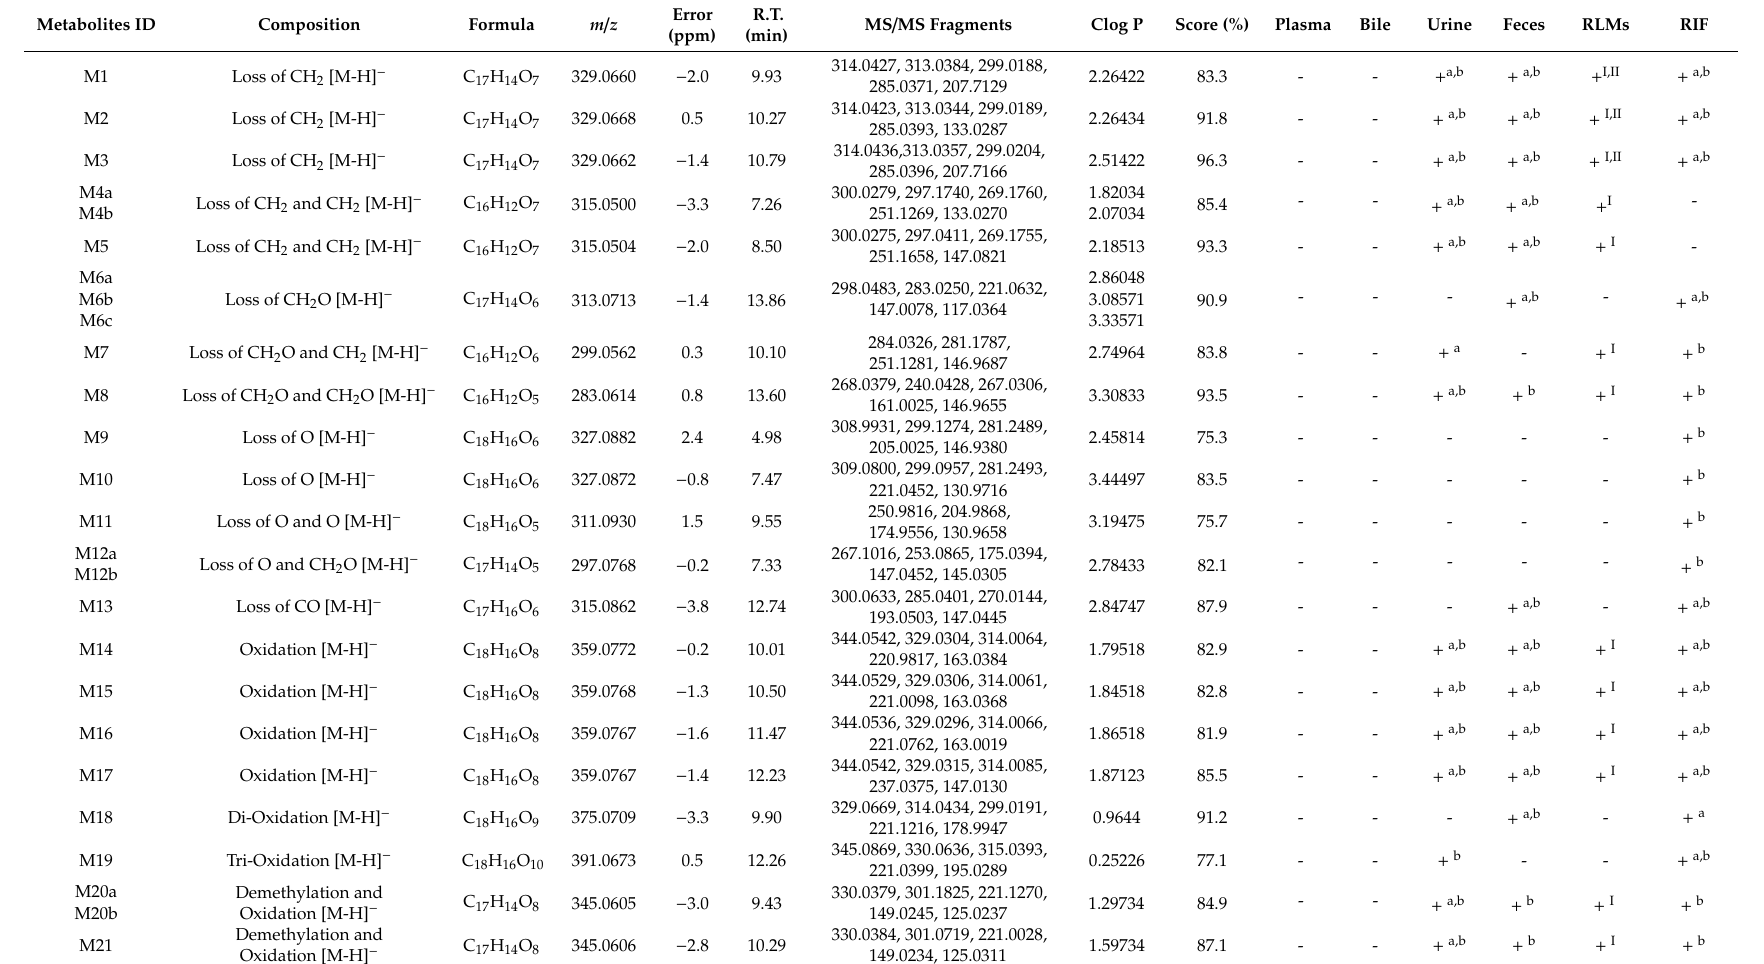
Table 1. Summary of metabolites of eupatorin in vivo and in